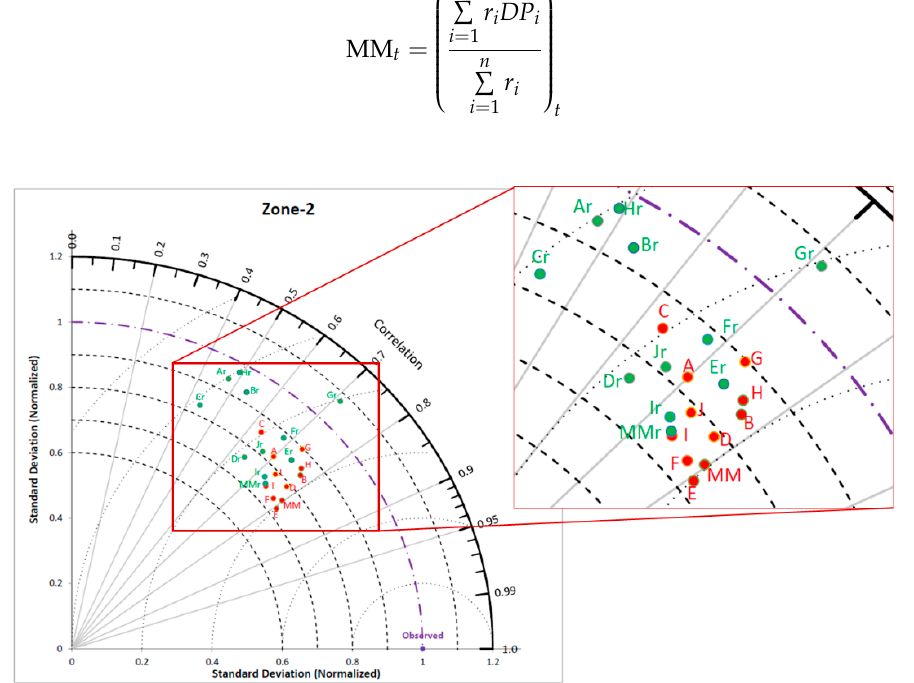
Figure 9. Taylor diagram for downscaling with Re-Obs and GCM-Obs models for zone 2. Notations are same as those used in Figure 8.